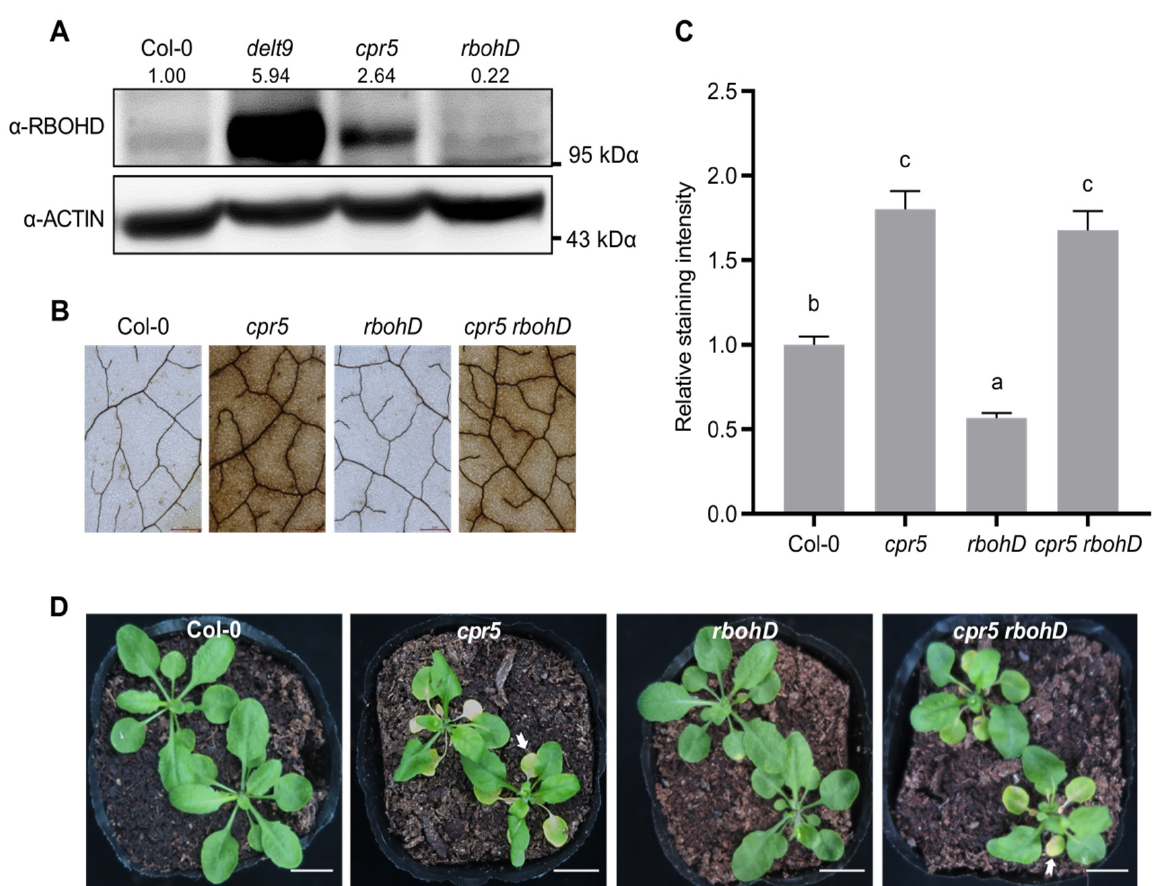
Figure 3. RBOHD is not responsible for excessive ROS in cpr5 mutants. ( A ) RBOHD accumulation was higher in the cpr5 mutants than in the wild-type (Col-0). Total proteins were extracted from 4-week-old plants and detected by immunoblot analysis with an α - RBOHD antibody as well as an α -ACTIN antibody as a loading control. Numbers at the top of the blots indicate the relative levels of RBOHD proteins normalized with the ACTIN levels. The experiment was repeated twice with similar results. ( B ) ROS accumulation was detected by 3,3 (cid:48) -diaminobenzidine (DAB) staining. The 5th–7th rosette leaves from 4-week-old plants were detached and stained with DAB solution. ROS production was visualized in form of dark brown precipitate in detached leaves. Representative leaves are shown. Scale bars = 2 mm. ( C ) Quantification of DAB staining intensity in ( B ). Relative DAB staining intensity per unit leaf area was measured using the ImageJ software. Data are means ± SE (n = 10). Letters above bars indicate significantly different values among groups ( p ≤ 0.05; one-way ANOVA). ( D ) Introduction of rbohD into the cpr5 mutants did not prevent premature leaf senescence. The 4-week-old plants were photographed. White arrows indicate early leaf senescence. Scale bars = 1